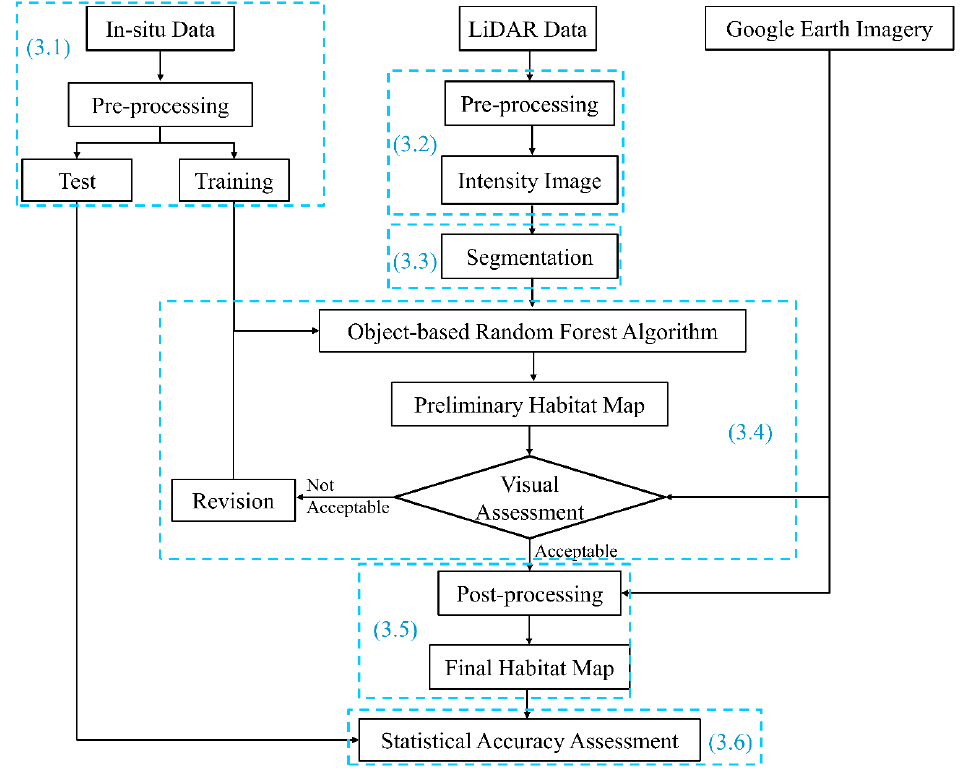
Figure 2. The flowchart of the classification model for marine habitat mapping.